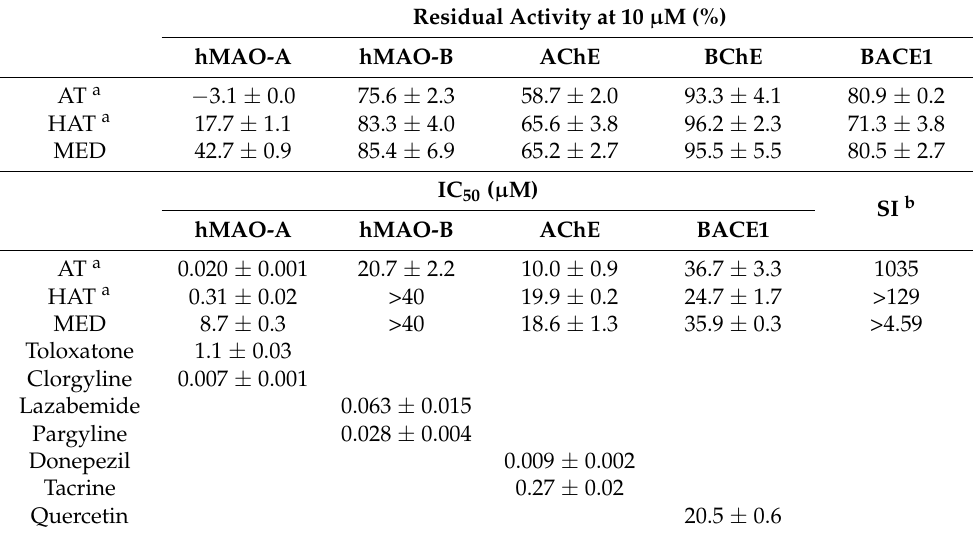
Table 4. Analysis of enzyme inhibitory activities of the isolated